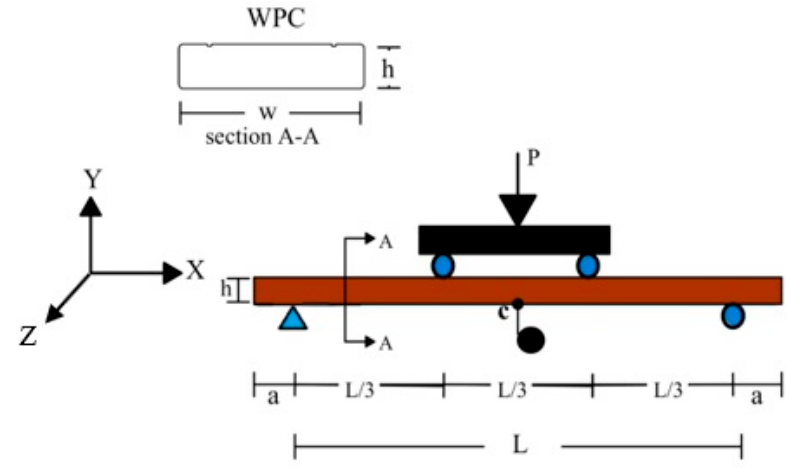
Figure 1. Schematic of the WPC lumber specimen in creep in a four-point bending test setup configuration. The grooved upper layer of the Section A-A is located at the loading noses along the X -axis, and the flat bottom layer of the section is located at the supports side along the X -axis.